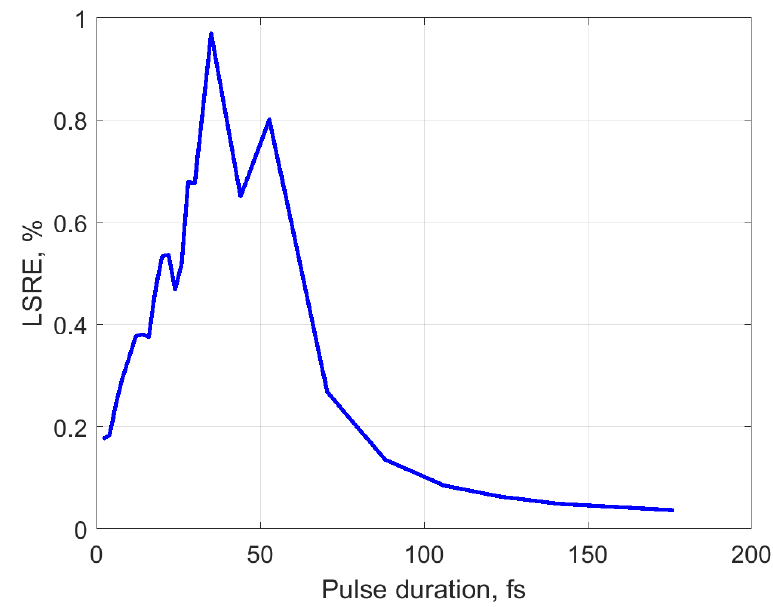
Figure 3. The dependencies LSRE on the input pulse duration.